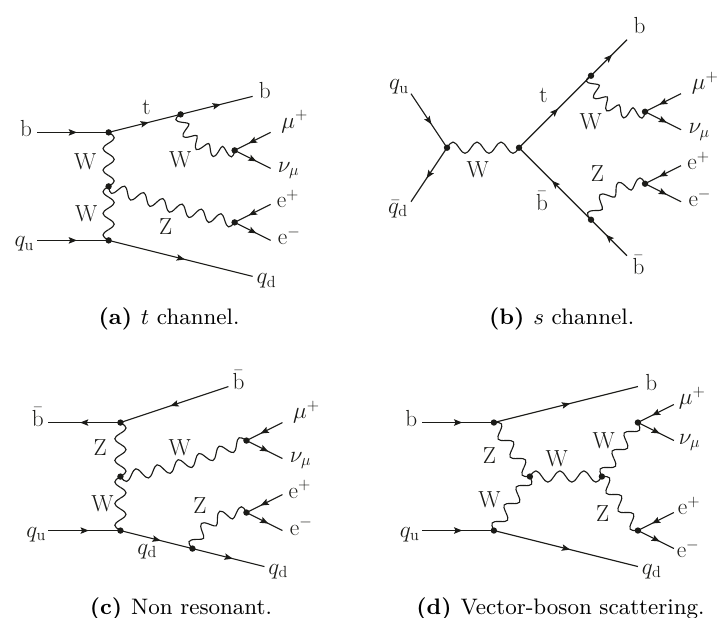
Figure 1. Sample tree-level diagrams contributing at O ( α 6 ) to off-shell tZj production at the